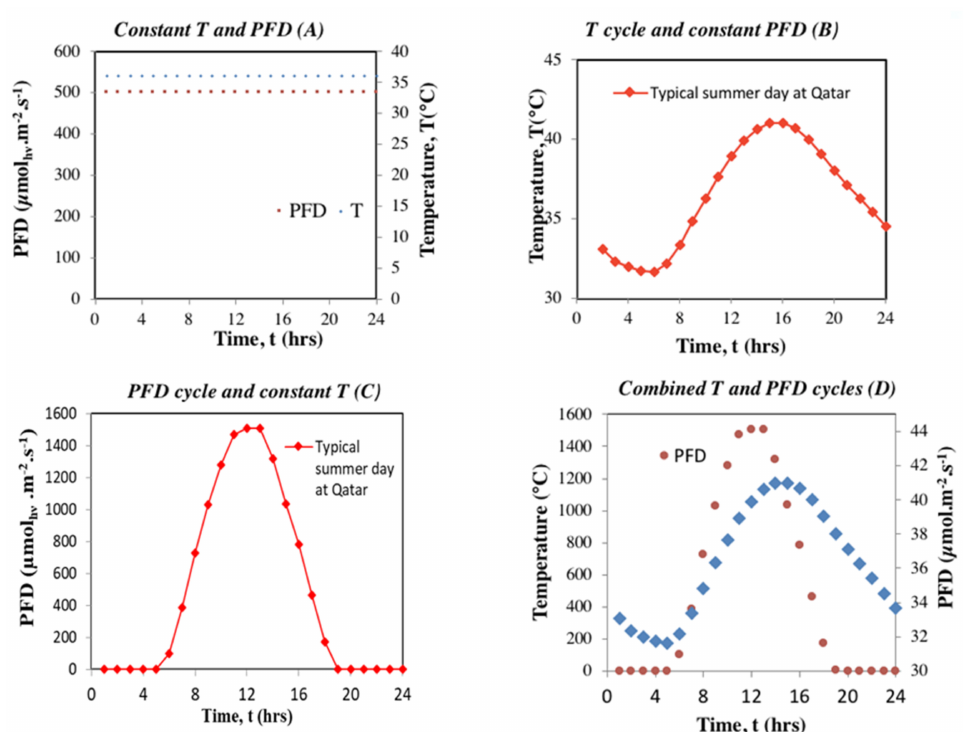
Figure 2. Experimental design of the cultivation of the N . sp. QU130 under light and temperature fluctuation regimes. (Regime ( A ): constant light and temperature; Regime ( B ): Temperature cycles with constant light; Regime ( C ): Light cycle with constant temperature; Regime ( D ): Combined light and temperature